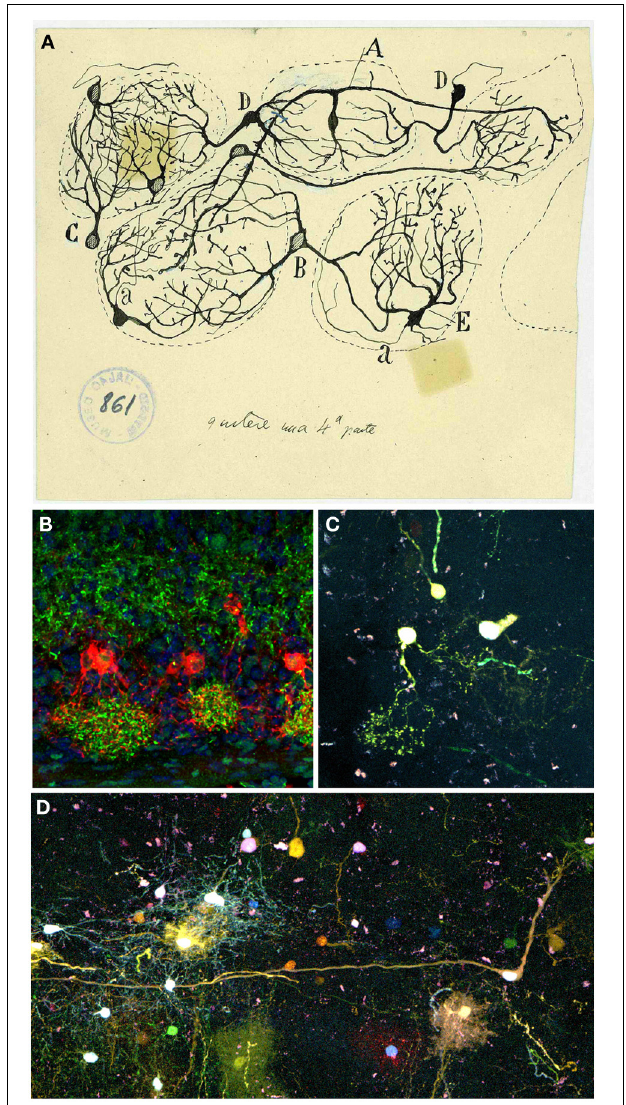
FIGURE 6 | Periglomerular cells. (A) Original drawing by Cajal’s disciple Blanes, showing periglomerular cells of a cat glomerular layer (Blanes, 1898). Cell branching into three glomeruli (A) . Biglomerular cells (B–D) . Monoglomerular cells (C–E) . (a) Axon. Cajal Legacy (Instituto Cajal, CSIC, Madrid, Spain). (B) Periglomerular cells immunolabeled for tyrosine hydroxylase (TH, red) protein and Dab1 protein (green) on mouse olfactory bulb sections at P3. Panel was taken by Eduardo Martin-López. (C,D) Adult periglomerular cells contributing to one (C) or more glomeruli (D) labeled after E13 in utero electroporation of different plasmids with the UbC-Star Track method (Figueres-Oñate and López-Mascaraque,